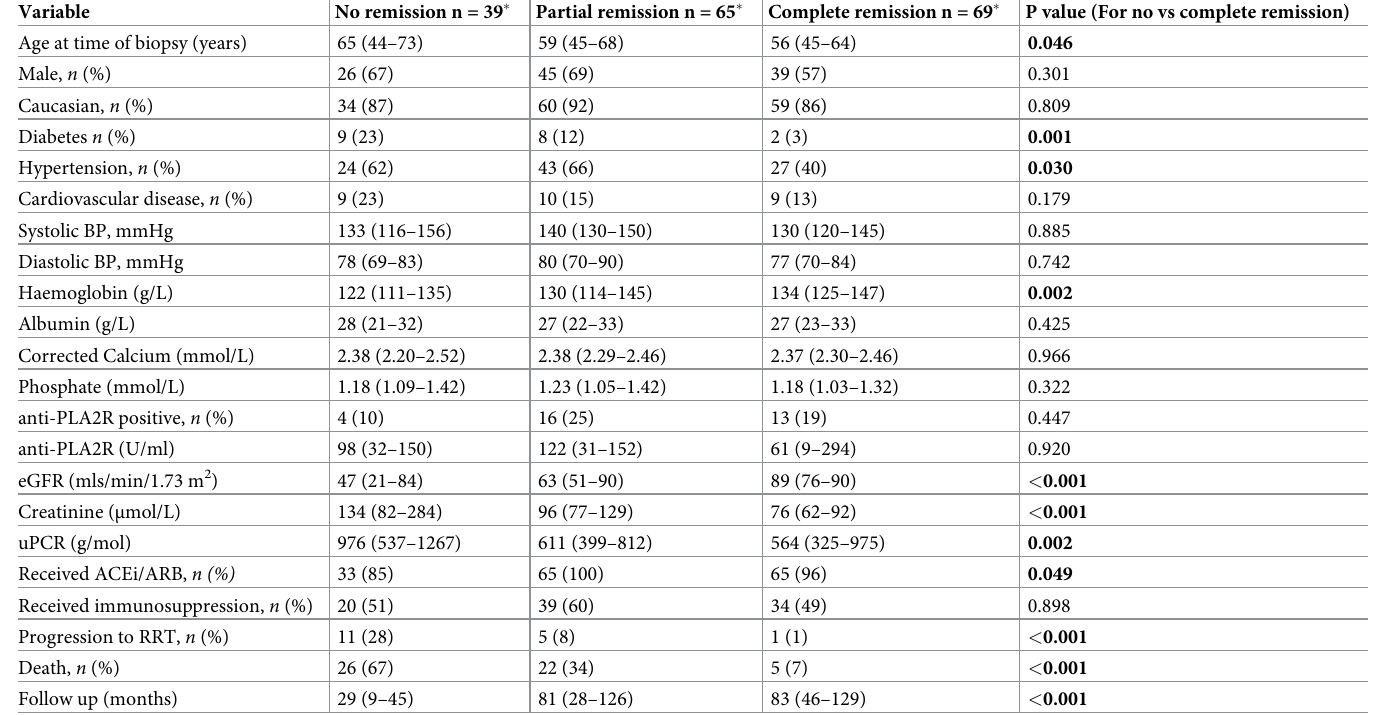
Table 4. Baseline characteristics and outcomes by remission (no, partial, or complete).